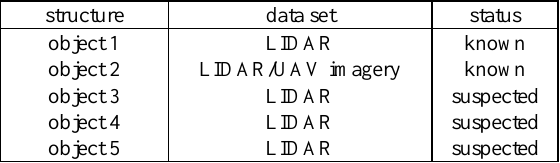
Tab. 1. Data used for the